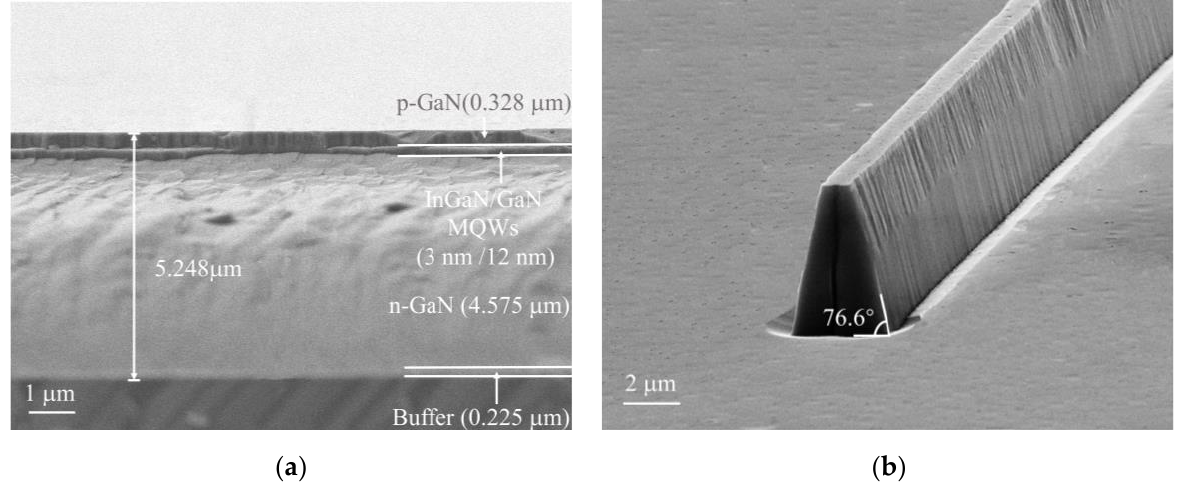
Figure 1. SEM of ( a ) the wafer cross section and ( b ) the triangular-like ridge cavity. The PL spectrum of the triangular-like ridge cavity at room-temperature is shown in Figure 2. In Figure 2(a), there are two emission peaks, located at 434 nm (P434) and